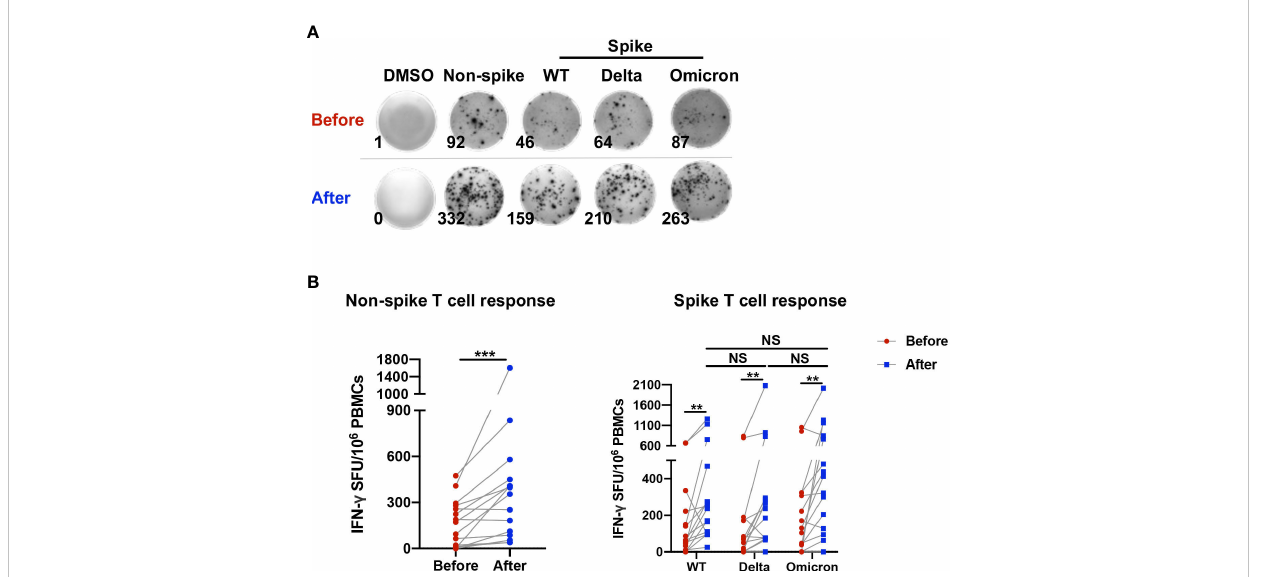
FIGURE 1 T cell reactivity to non-spike and spike antigens induced by a third dose of CoronaVac. PBMCs obtained before and 1-2 weeks after the third dose of CoronaVac were stimulated with spike peptide pools from WT, Delta, and Omicron as well as a non-spike peptide pool from WT SARS-CoV-2 for 20 h. ELISpot assay was performed on PBMCs. No stimulation (DMSO only) was served as negative control. (A) Representative photos of ELISpot wells were presented. (B) The number of IFN- g -producing T cells was enumerated as the spot-forming units (SFU) per 10 6 PBMCs. Points and connecting lines represent raw data for a single participant. Data were normalized against the background value in the DMSO stimulation. Comparisons were performed via Wilcoxon matched-pairs signed rank test between two groups or Friedman test with Dunn ’ s multiple comparisons test among multiple groups. n = 15. ** p < 0.01, *** p < 0.001. NS, not signi fi